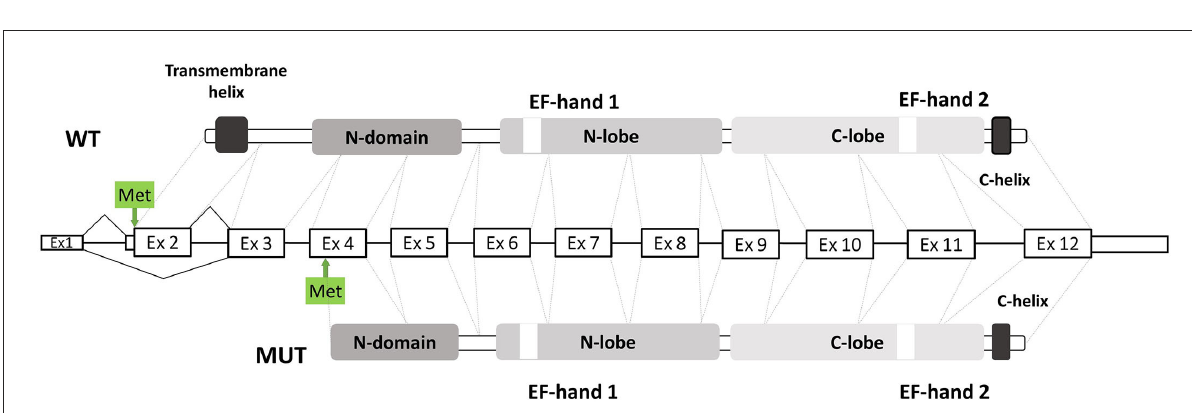
FIGURE2 Scheme of exonic structure of WT MICU1 gene presents in the middle. Domain structure is shown in greys. Original ATG codon and predicted ATG codon shown with arrows and green